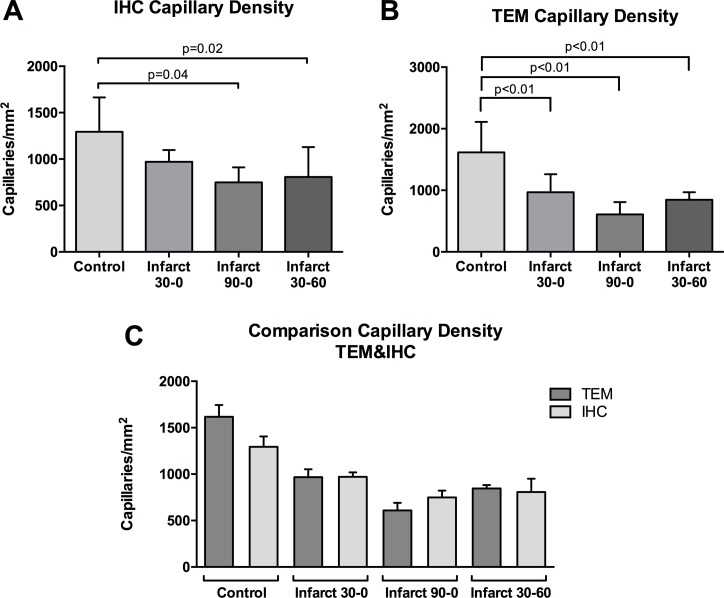
Capillary density.Immunohistochemical analysis of frozen tissue samples. A Quantification of capillary density by immunohistochemistry (IHC). B Quantification of capillary density by Transmission Electron Microscopy (TEM). C Comparison of capillary density between TEM and IHC. Capillary density is expressed as the number of capillaries per square millimeter.